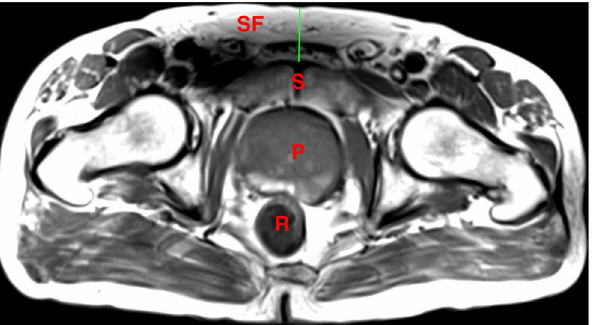
Figure 4. Measurement of subcutaneous fat thickness from the perpendicular distance between symphysis pubis and skin at the level of the superior pubic ramus on T 1 weighted transverse pelvis MRI. P = Prostate gland; R = Rectum; S = Symphysis pubis; SF = Subcutaneous fat.